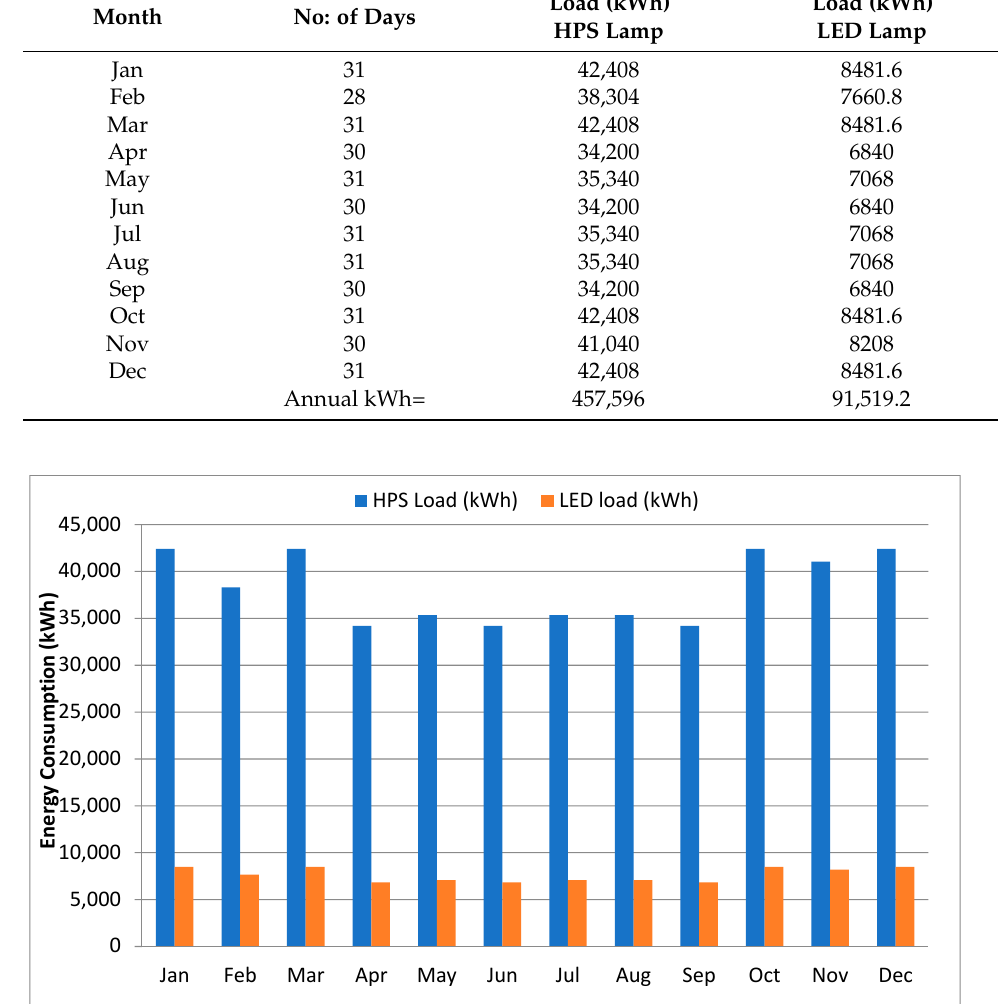
Figure 3. Monthly load consumption of HPS and LED lamps.